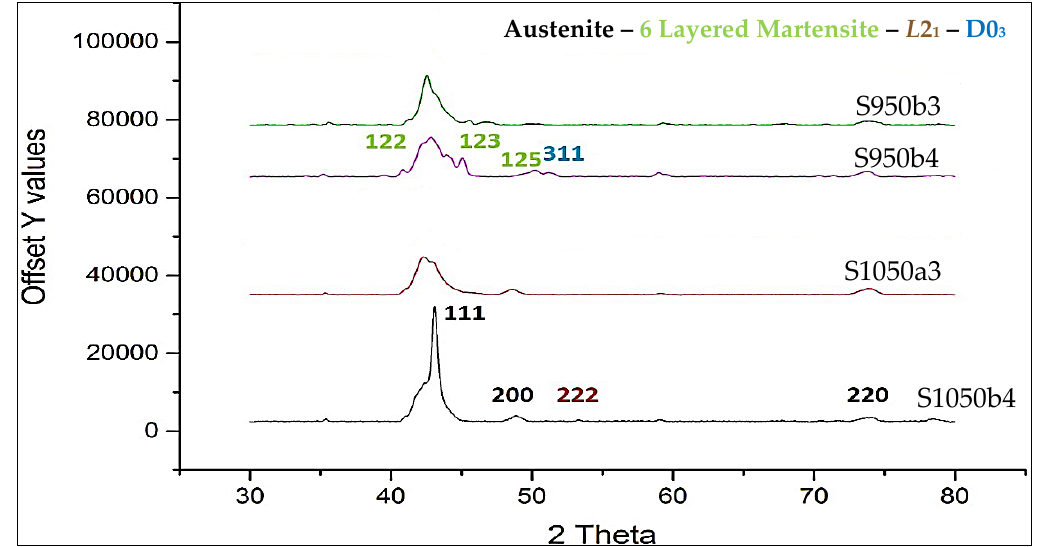
Figure 14. XRD patterns of: ( a ) S1050a2 and ( b ) S1050a1.